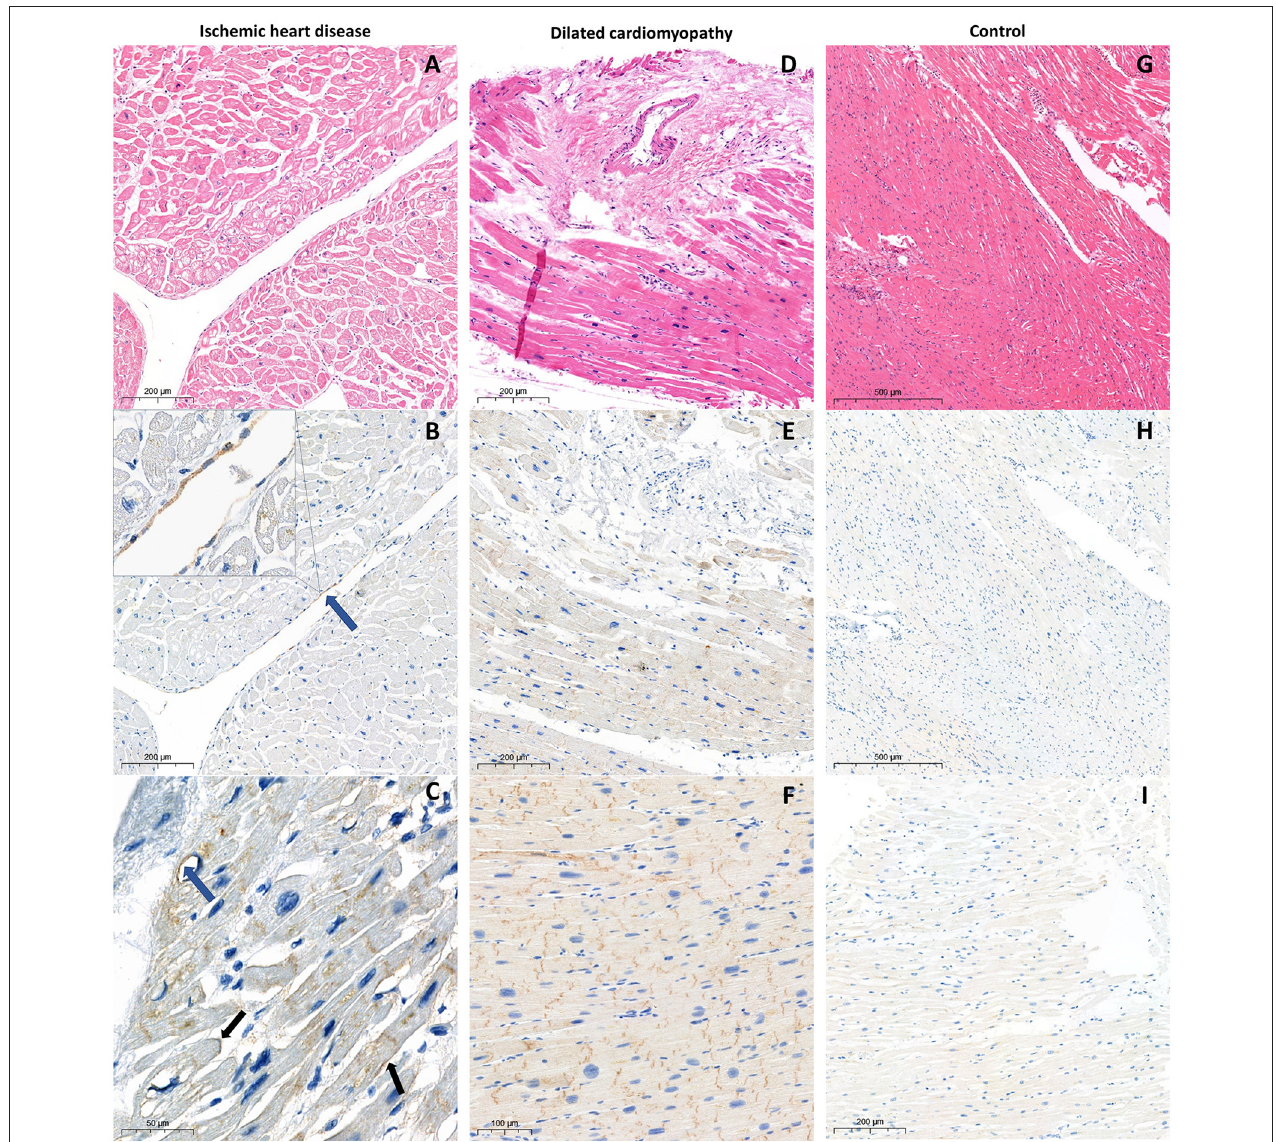
FIGURE 1 | Histological and immunohistological examination of the myocardium samples from the patient with ischemic heart disease (A) hematoxylin and eosin staining; (B,C) PD-L1 staining with CMPS 5% and 20% respectively. Blue arrows indicate positive endothelial PD-L1 expression, black arrows indicate positive membrane PD-L1 expression; from the patient with dilated cardiomyopathy (D) hematoxylin and eosin staining; (E,F) PD-L1 expression in cytoplasm and intercalated discs, without endothelial, perivascular, and membrane patterns with ICDPS 70% and 100% respectively; from the control without ICI treatment (G) hematoxylin and eosin staining; (H) absence of PD-L1 expression; (I) extremely poor cytoplasmic PD-L1 expression.